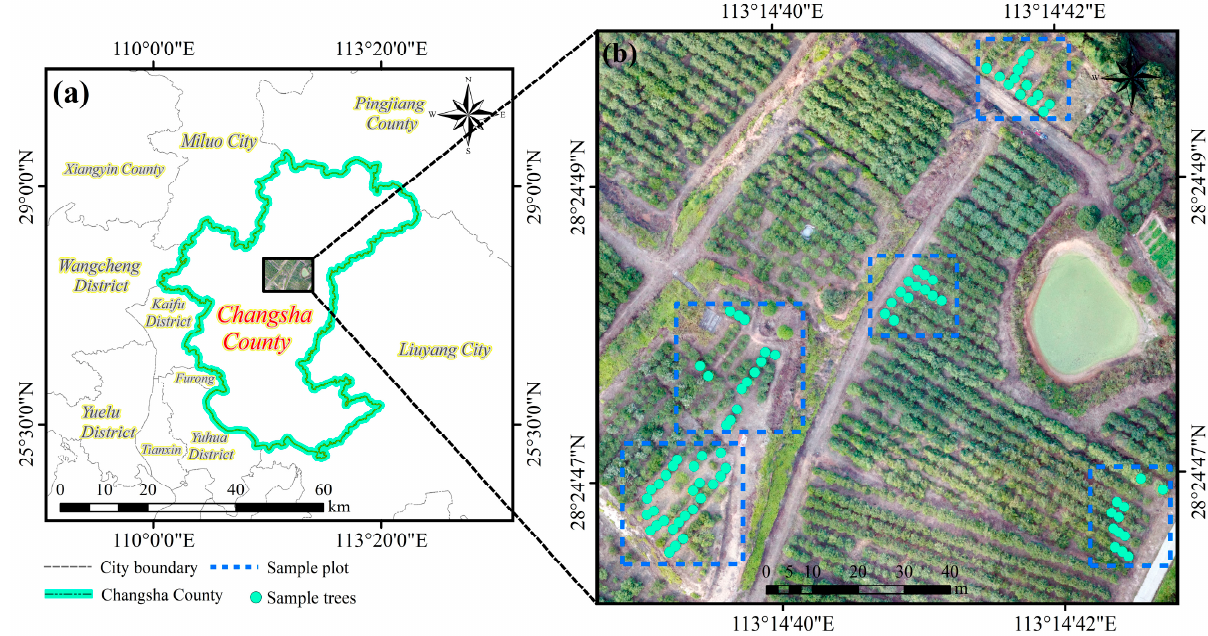
Figure 1. ( a ) Location of the study area and ( b ) the sample tree distribution.